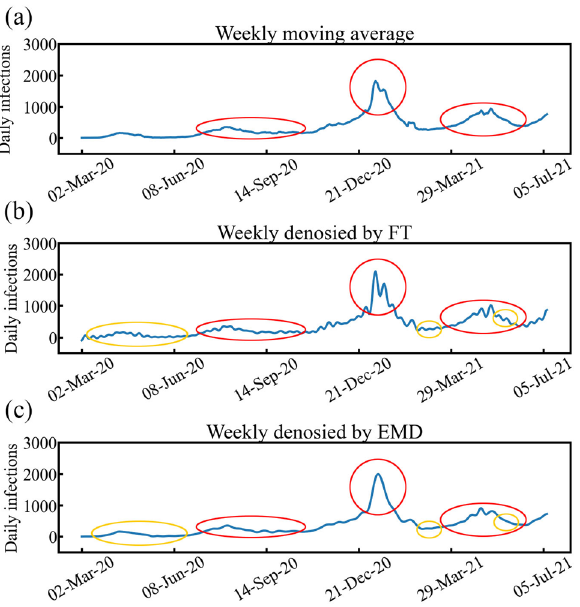
Figure 4. Comparison among ( a ) moving average, ( b ) FT, and ( c ) EMD in weekly denoised